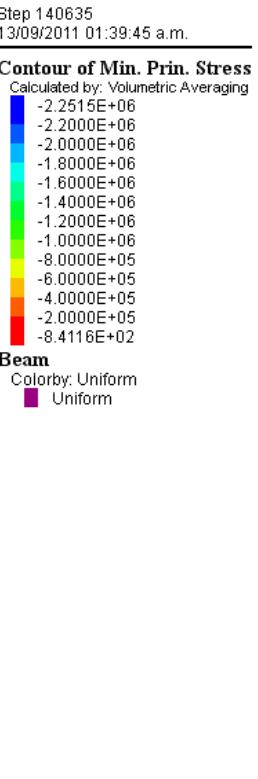
Figure 23. Contours of major principal stress σ 1 (in N/m 2 ) in concrete elements. Minimum parame- ters.